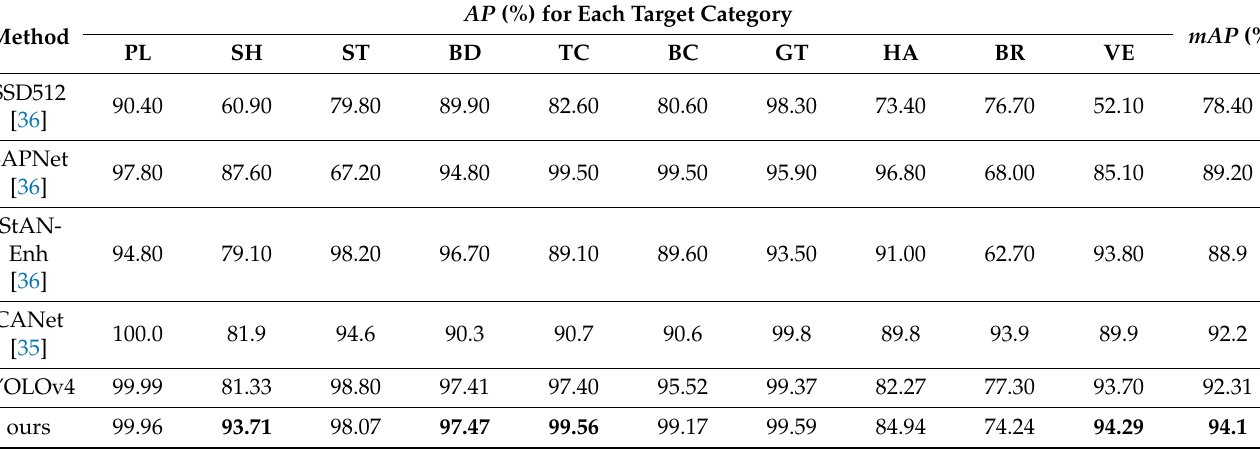
Table 5. Comparison of results from the NWPU VHR-10 dataset.